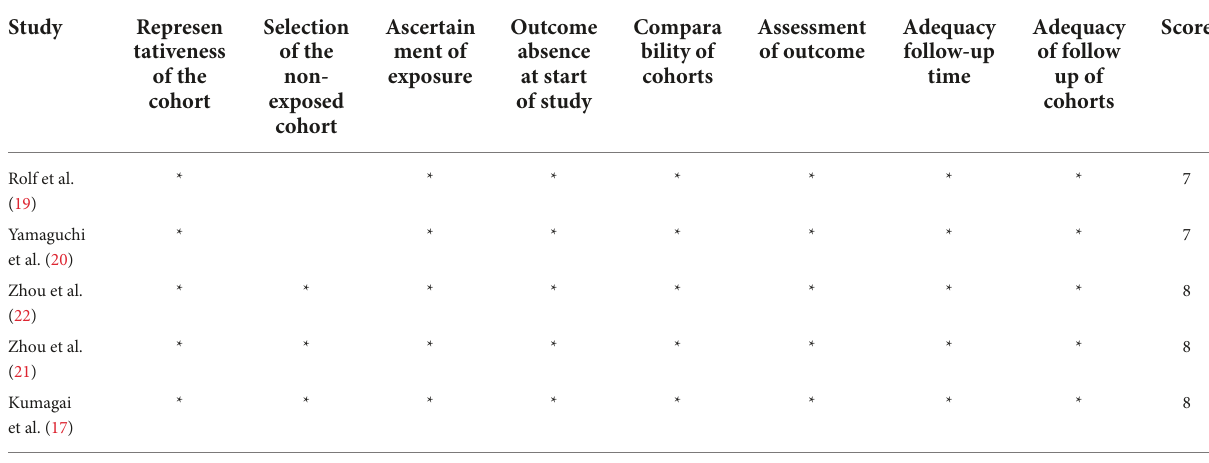
TABLE 3 Quality assessment of cohort